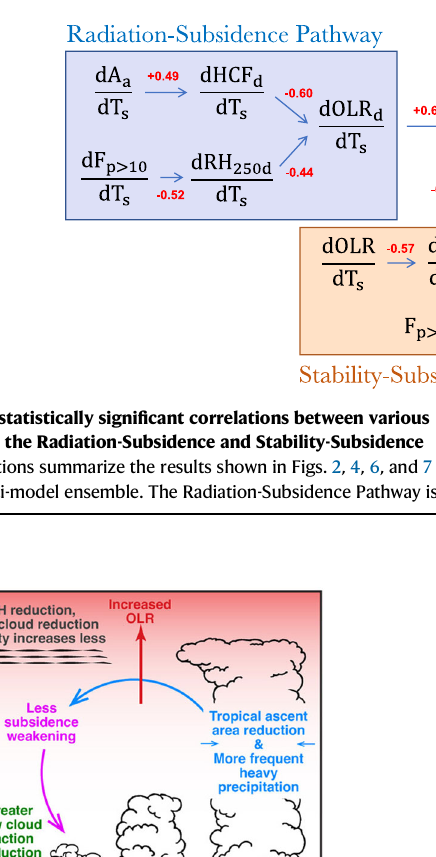
Fig. 10 | A summary schematic of the Radiation-Subsidence and Stability- Subsidence Pathways. A summary schematic illustrating how changes to deep convection link to the low cloud feedback by modifying upper tropospheric properties that affect the subsidence rate.